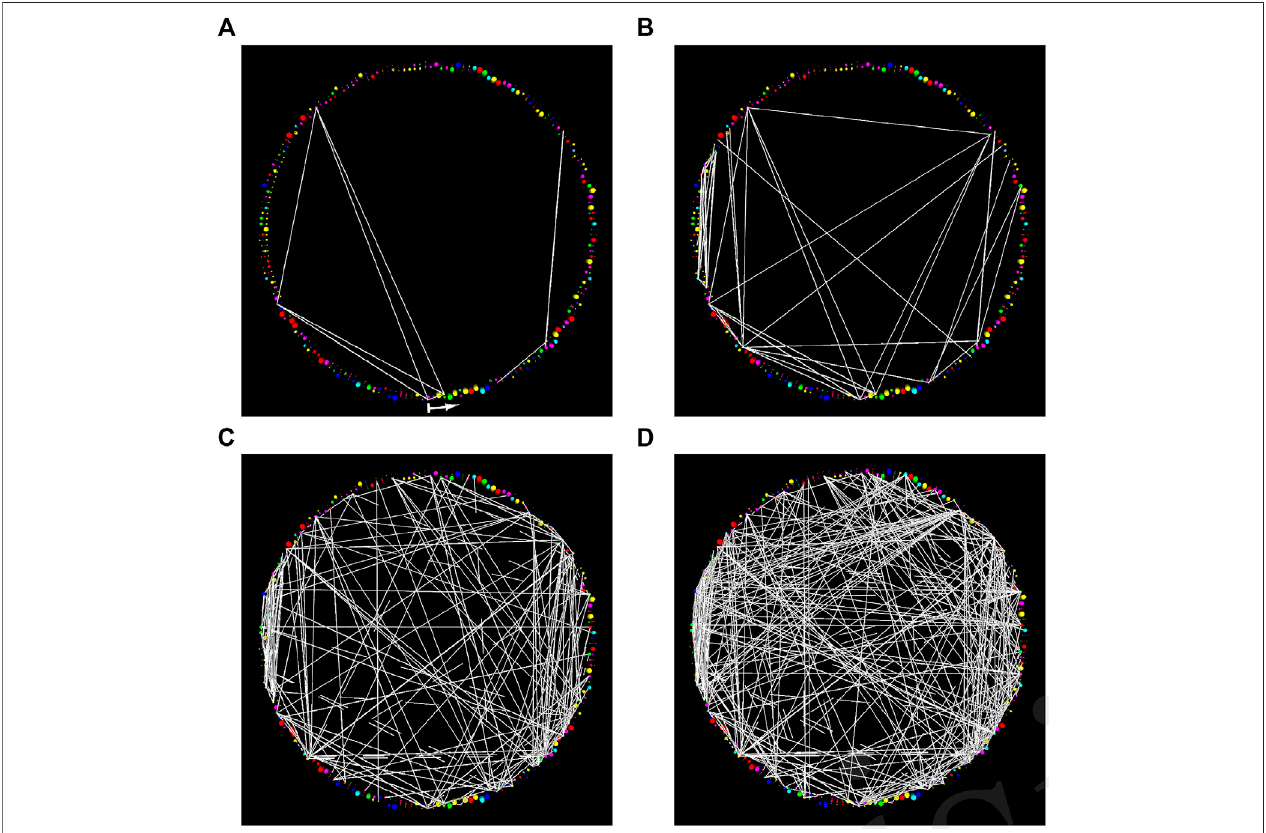
FIGURE 1 | StickWRLD presents the user with an interactive interface to a (pseudo) radial-layout node-link diagram of residue co-evolution statistics. The family (residue identity) position-speci fi c scoring matrix (PSSM) is arranged sequentially around the periphery of a cylinder and edges connecting co-evolving residues are drawn between their corresponding PSSM positions. These diagrams can contain as much or as little of the complete set of co-evolution statistics as the user desires, and can be rapidly “ dithered ” around any given set of parameters to see how small changes in parameter choice change the displayed subset of residue-pair statistics.Inthis fi gure,diagrams showStickWRLDvisualizationsforthecorrelatedmutationswithinadenylate kinase,extractedsolely fromthePfam (Punta etal., 2012) sequence alignments. They are arranged in order of decreasing statistical signi fi cance. The visually salient “ clouds ” or clusters of edges visible in (D) are indicative of structural contacts, despite the fact that at p ≤ 0.1 they are well within the noise fl oor. T r > = 0.15 for all images. The start of the arrow in sub fi gure (A) indicates the N-terminal of the protein and it points in the direction of increasing sequence coordinates. (A) The most signi fi cant correlations, with p ≤ 0.005, have no obvious visual pattern. (B) Asthesigni fi canceisweakened,here p ≤ 0.010,morecorrelations appear. (C) Whencorrelations with p aspooras0.050areshown,distinctpatternsbegin to appear in the cloud of minimal-signi fi cance correlations. (D) Even when the signi fi cance is only p ≤ 0.100, the cloud of weak correlations remains visually focused around certain areas in the